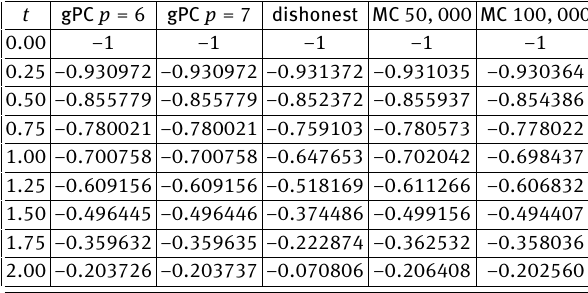
Table 7: Approximation of E [ X ( t )] . Example 4.2, assuming independent random data.